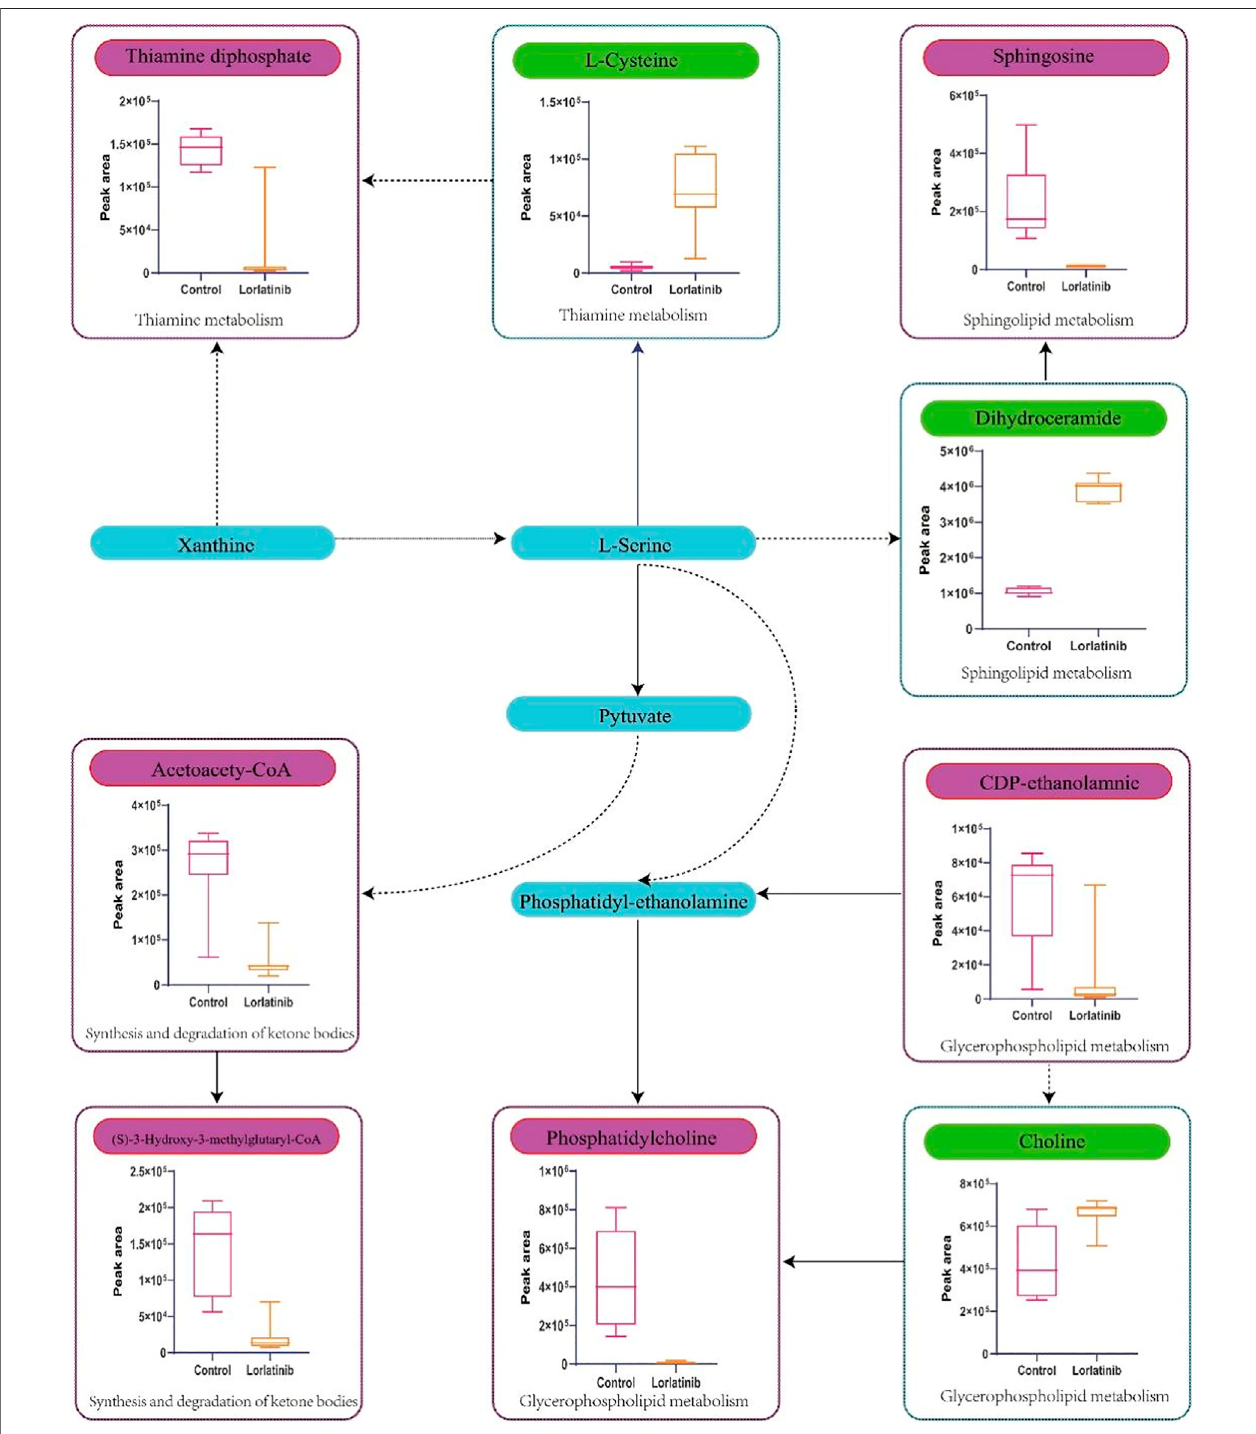
FIGURE 4 | Schematic diagram of the metabolic pathways related to lorlatinib and the trends of biomarkers enriched in these metabolic pathways. The notations areasfollows:( ↑ )ingreen,metabolitehigherinthelorlatinibgroupthanincontrolgroup;( ↓ )inred,metabolitelowerinthelorlatinibgroupthanincontrolgroup.Therelated metabolic pathways are graphed in blue boxes.